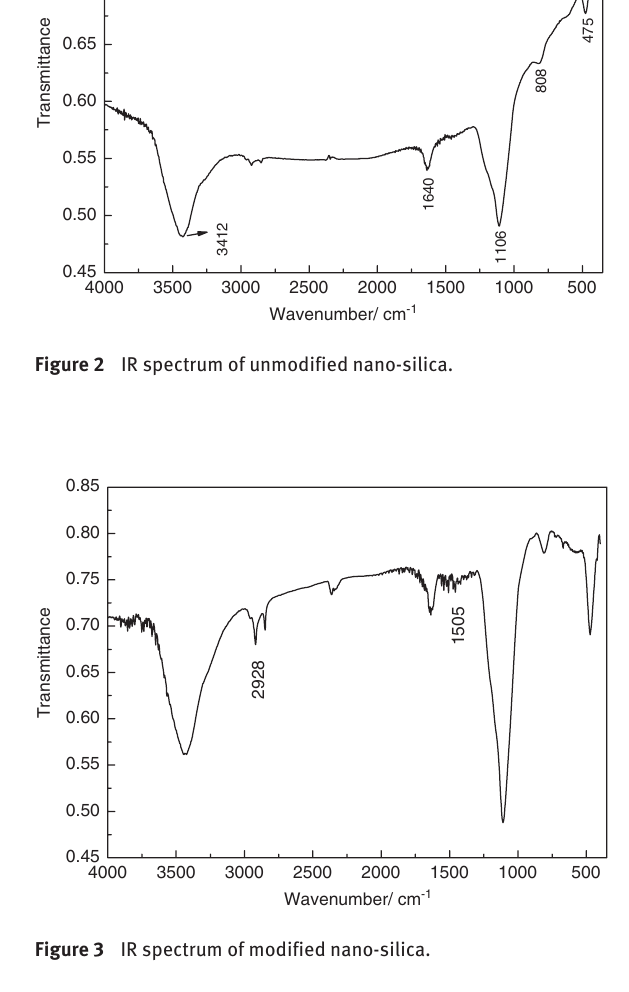
Figure 3 IR spectrum of modified nano-silica.